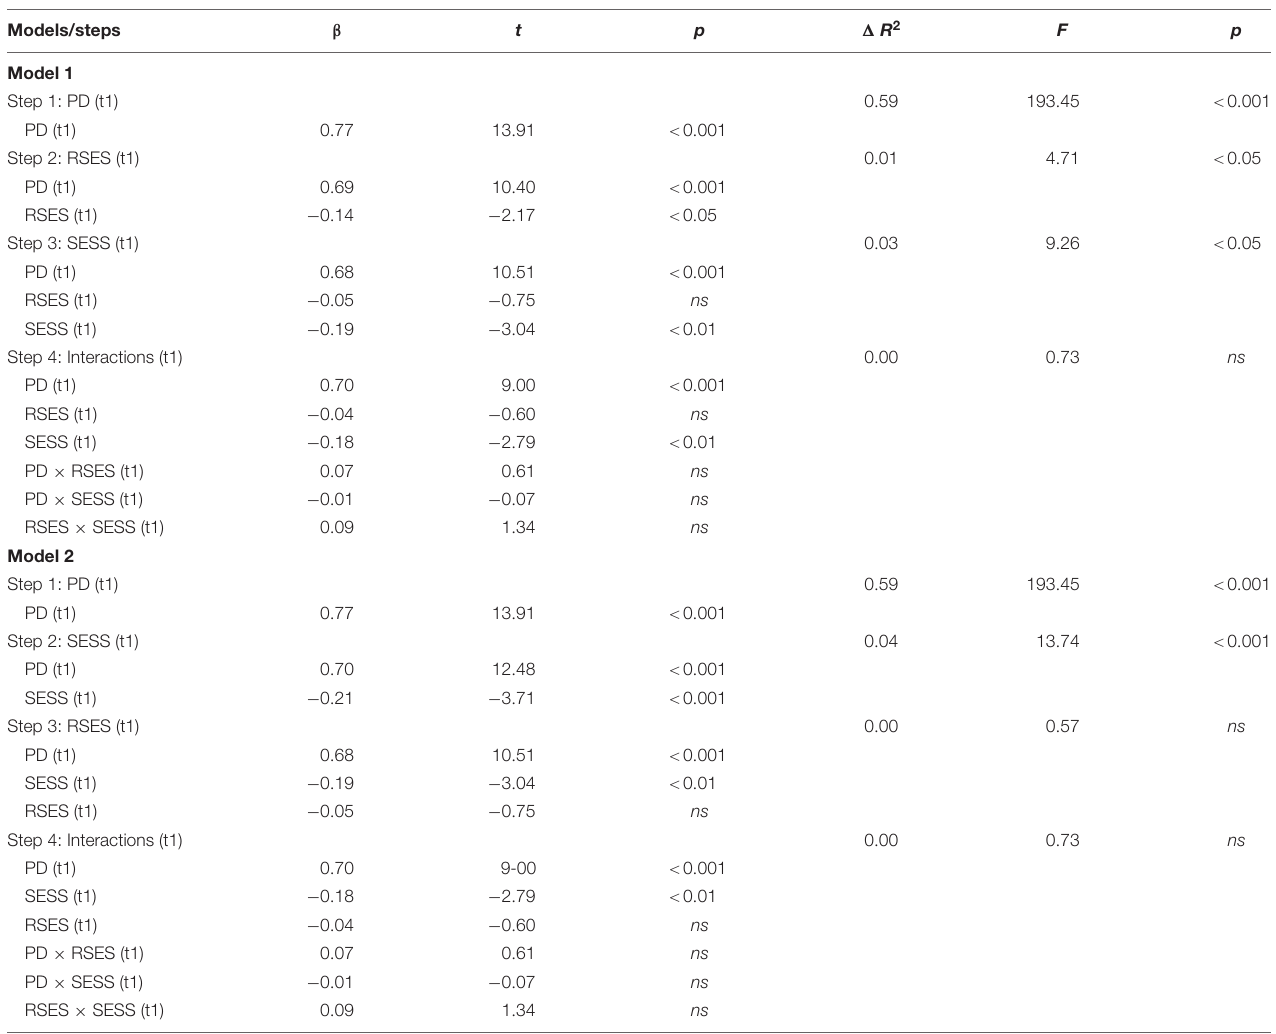
TABLE 4 | Comparisons of the RSES and SESS in the temporal prediction of psychological distress (PD) at Time 2 using multiple regression models ( N = 136). Models/steps Model